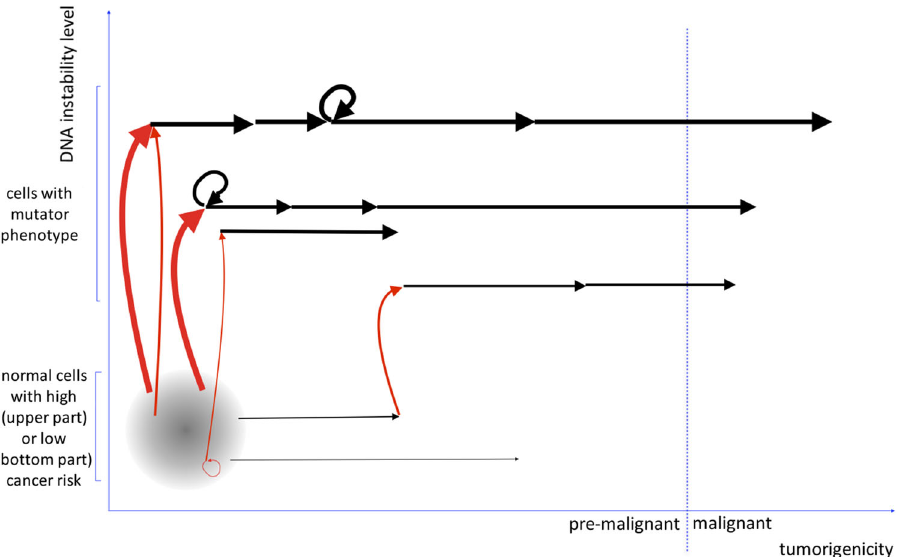
Fig. 2 Genetic mechanism leading to the acquisition of a malignant cancer phenotype in normal cells from a particular tissue. A normal cell from a speci fi c individual has an intrinsic DNA instability level and can be represented as a dot located within the gray area on the fi gure. The higher the cellular instability, the higher the cell is represented on the Y-axis. The position on the Y-axis for a particular individual is de fi ned by the combined genotype of all his genes involved in DNA surveillance (caretaker genes). Mutational events occur more frequently in cells with higher DNA instability, and can generate a mutator phenotype when affecting caretaker genes ( red arrows ). By analogy, cellular characteristics involved in tumorigenicity such as division rates, apoptosis, cellular interactions, … can jointly be plotted on the X-axis as regards to their contribution to the cancer phenotype of the cell. Mutations ( black arrows ) occurring in the genes supporting these underlying molecular mechanisms (gatekeeper genes) will arise more frequently in cells with higher genomic instability. Normal cells can already manifest